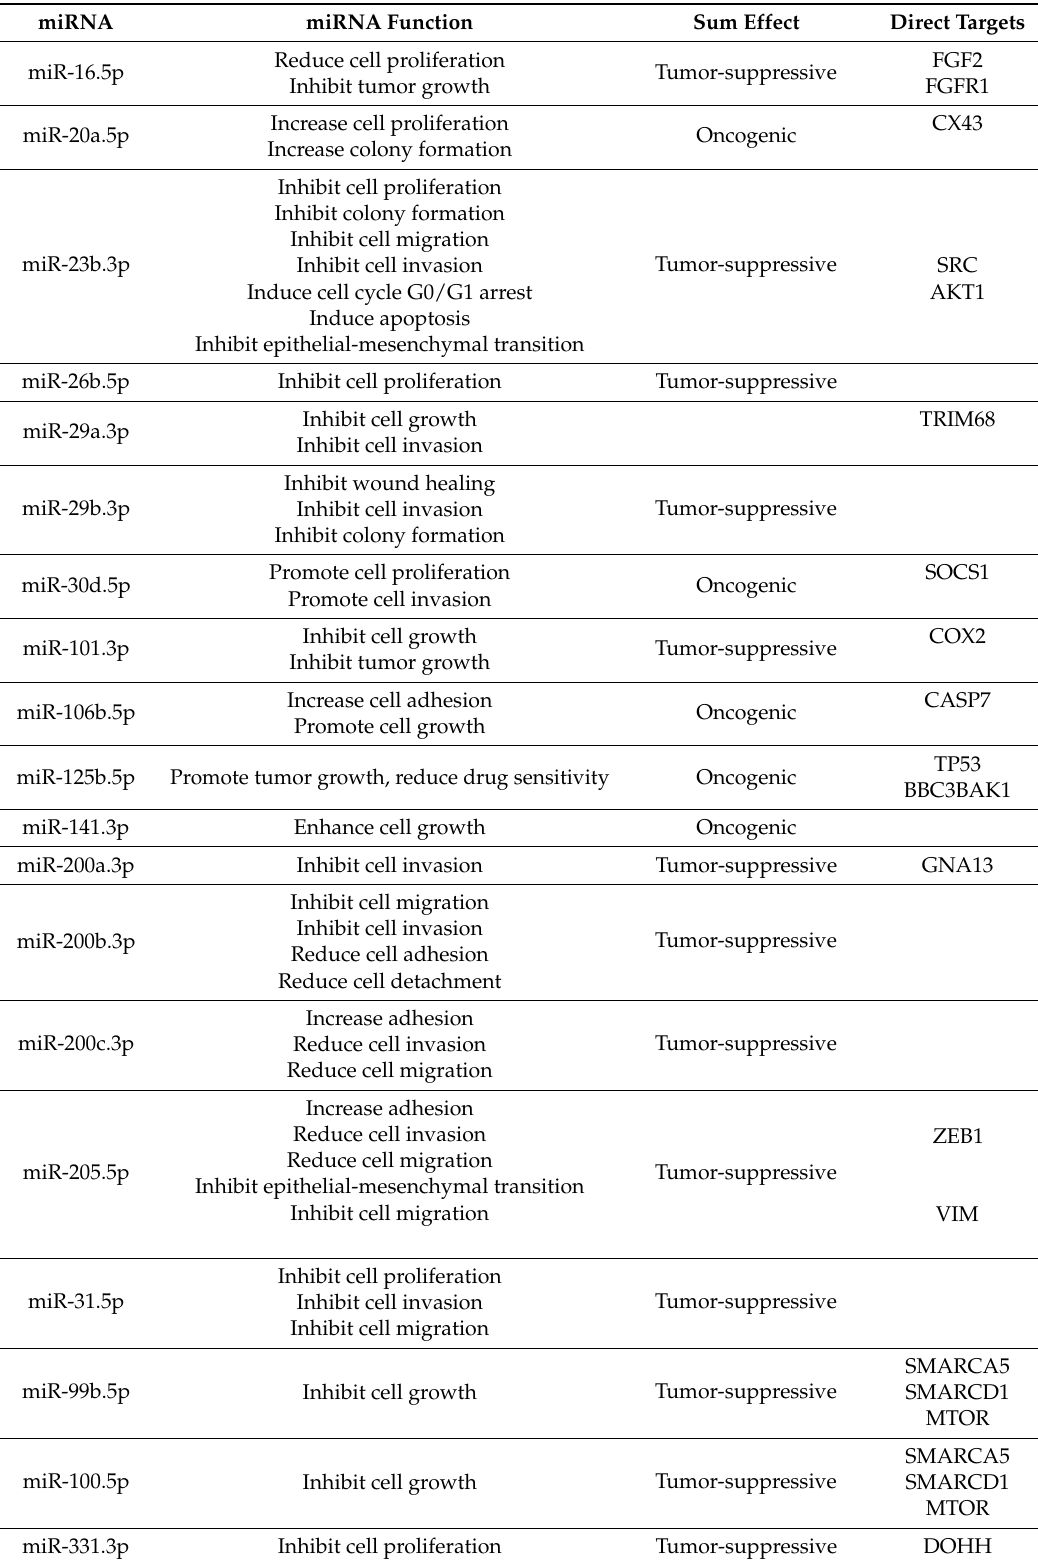
Table 5. Participation of identified predictors in the development and progression of prostate cancer according to the OncomiRDB